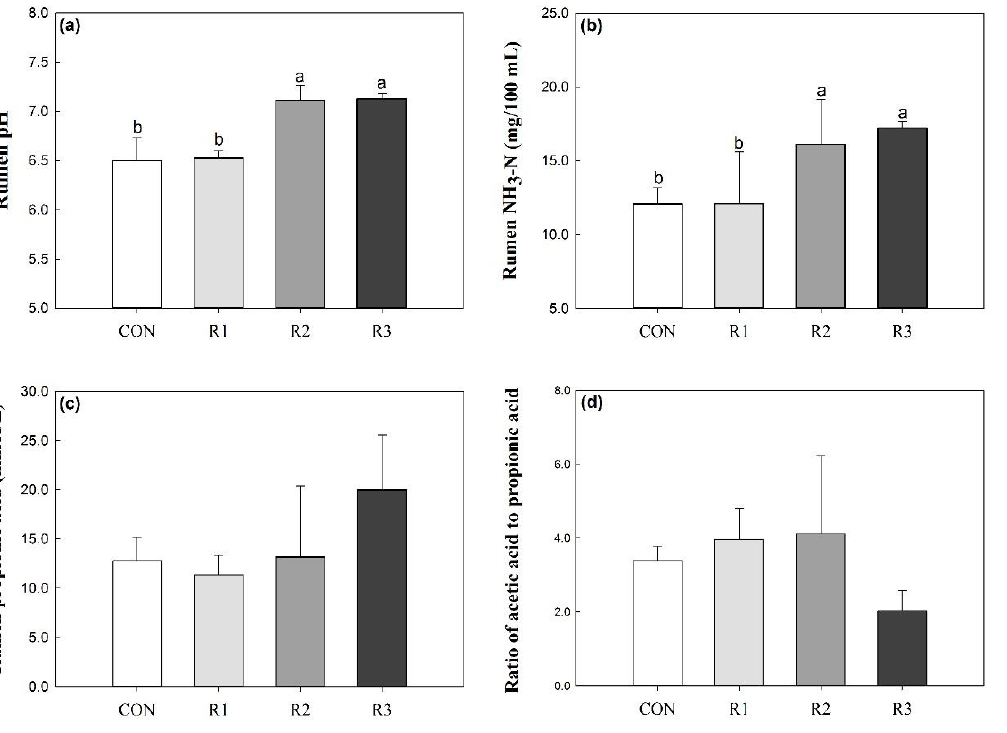
Figure 1. . Effects of corn silage and different chop lengths of ramie silage on (a) rumen pH, (b) rumen NH 3 -N, (c) rumen propionic acid and (d) ratio of acetic acid to propionic acid. CON, corn silage; R1, 1 cm chopped ramie silage; R2, 2 cm chopped ramie silage; R3, 3 cm chopped ramie silage.